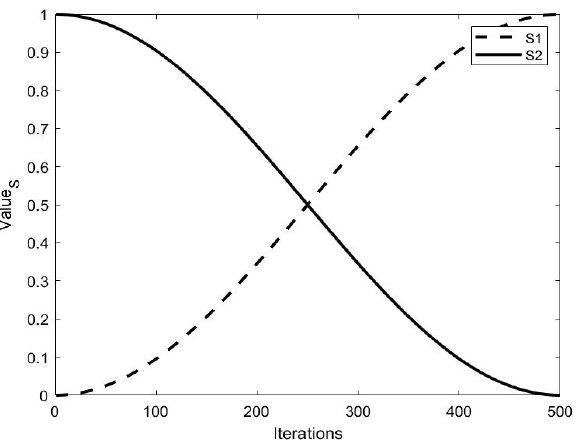
, S S with the number of iterations. Figure 1. The trend of the nonlinear weights S 1 , S 2 with the number of 1 2